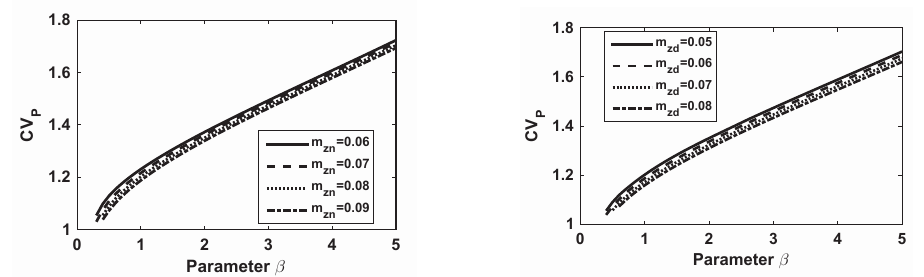
Figure 6. Perturbations in NPZD system lead higher coe ffi cient of variation of phytoplankton CV p drawn at di ff erent parameters (i) m zn and (ii) m zd . In each case, with higher perturbations higher CV p is quite evident.